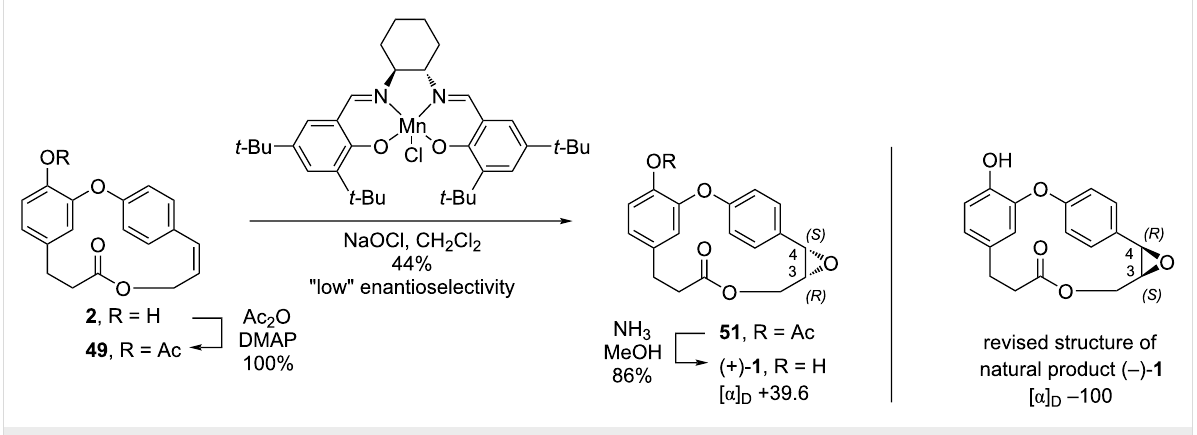
Scheme 9: Enantioselective synthesis of 1 by Rychnovsky and Hwang employing Jacobsen catalyst [41].